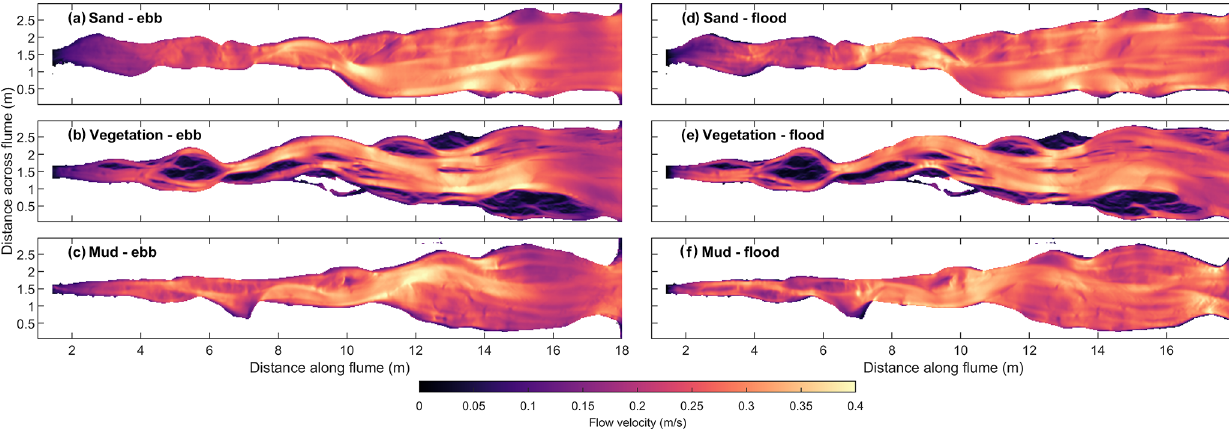
Figure 8. Maximum flow velocity calculated with the flow model for the end of the experiment during ebb (left) and during flood (right) in the experiments with (a) sand only, (b) vegetation and (c)